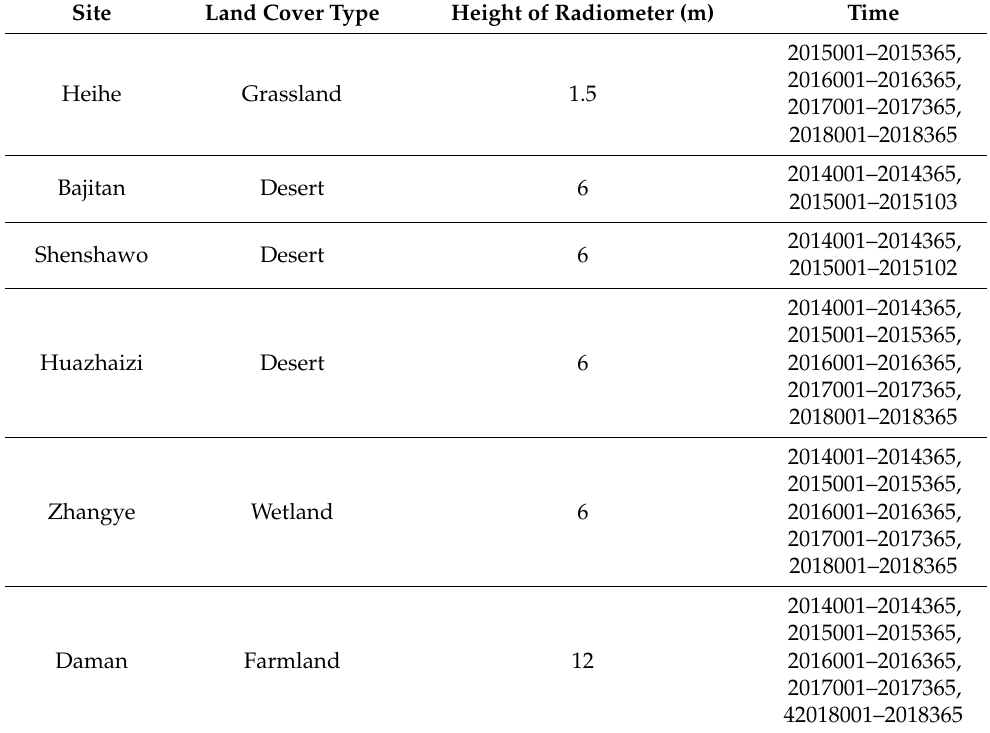
Table 2. Information of field observation